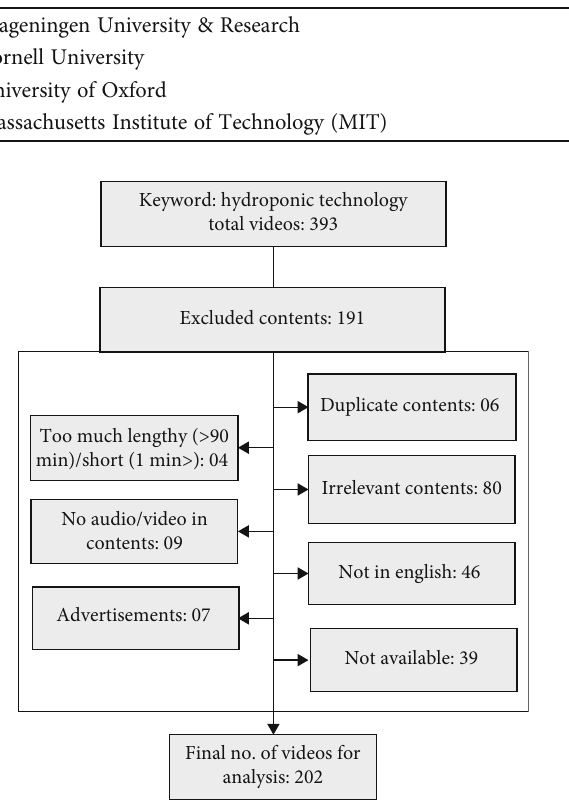
Figure 1: Details search methodology for included hydroponic technology videos.